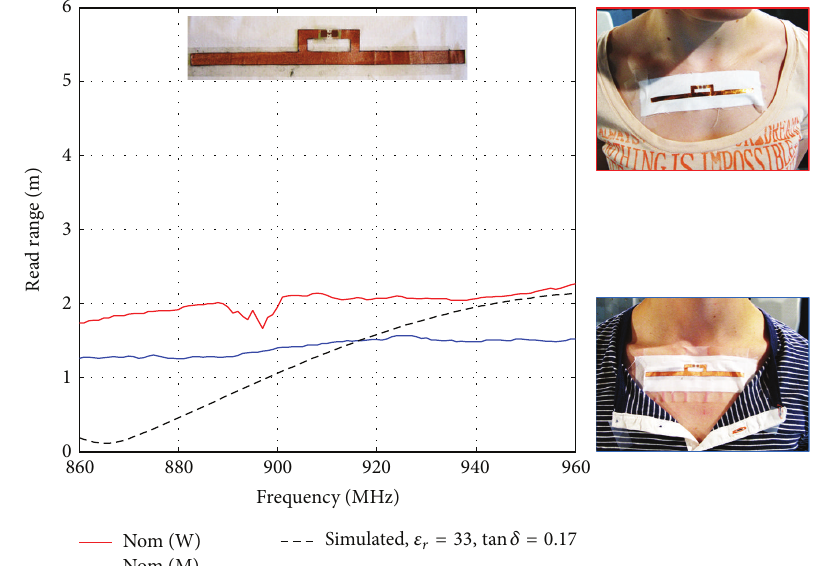
Figure 17: Measured and simulated fabric tag on human chest and on human chest model, respectively.